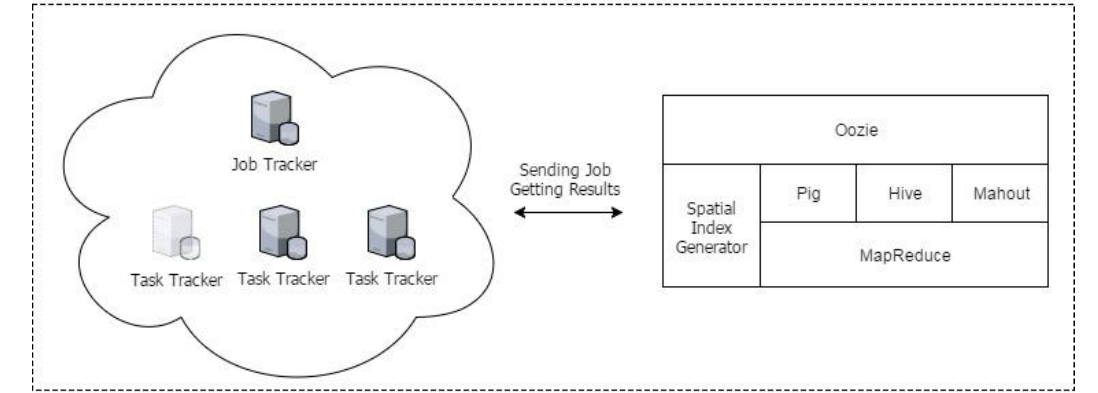
Figure 5. Computational layer